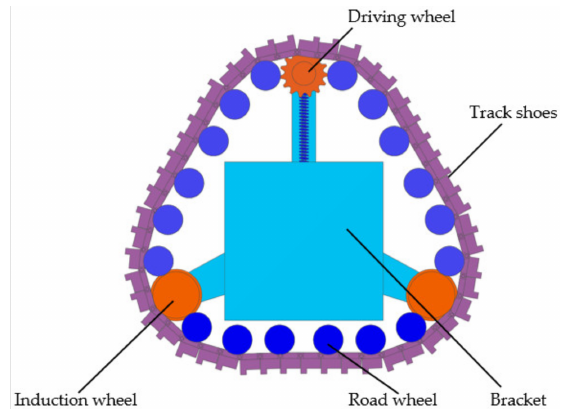
Figure 11. Triangular crawler mode of the walking